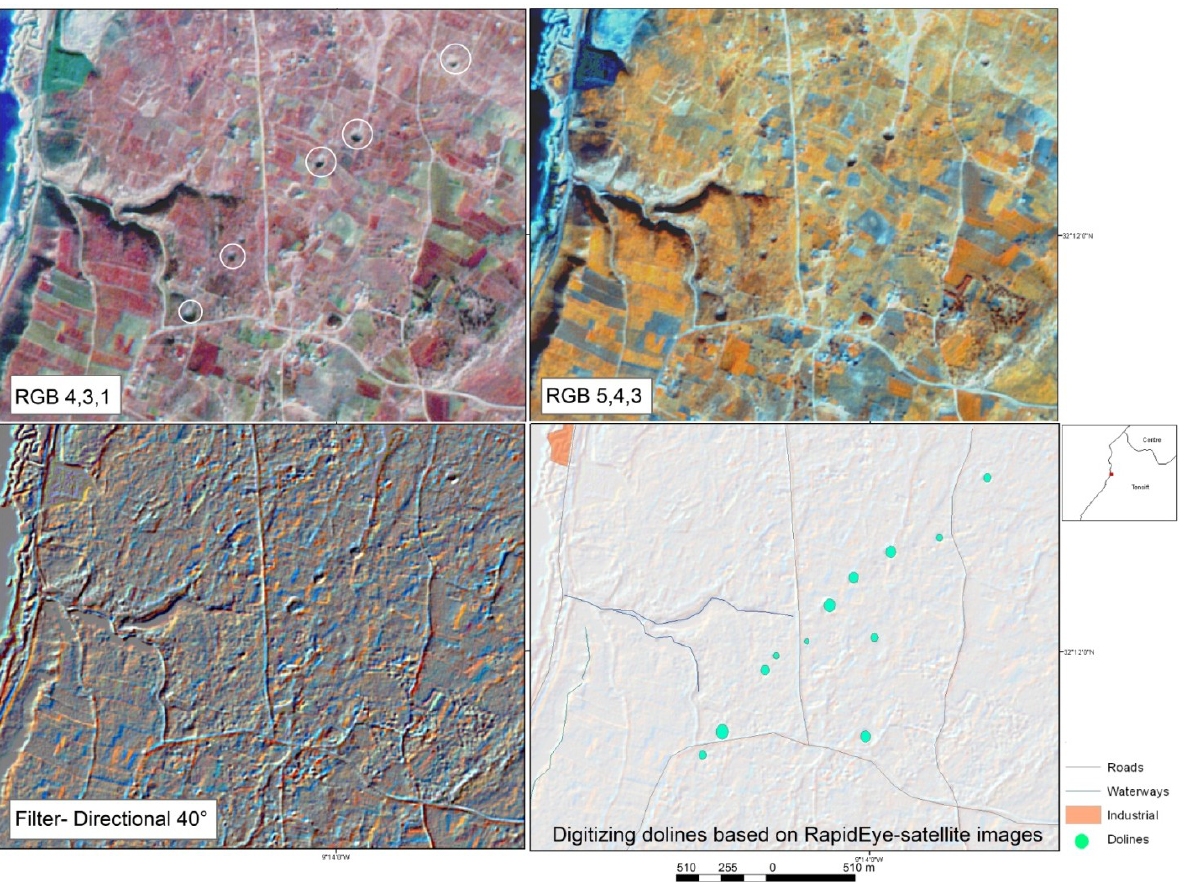
Figure 14. Dolines visible on RapidEye scenes (acquisition date: 4 December 2012), south of